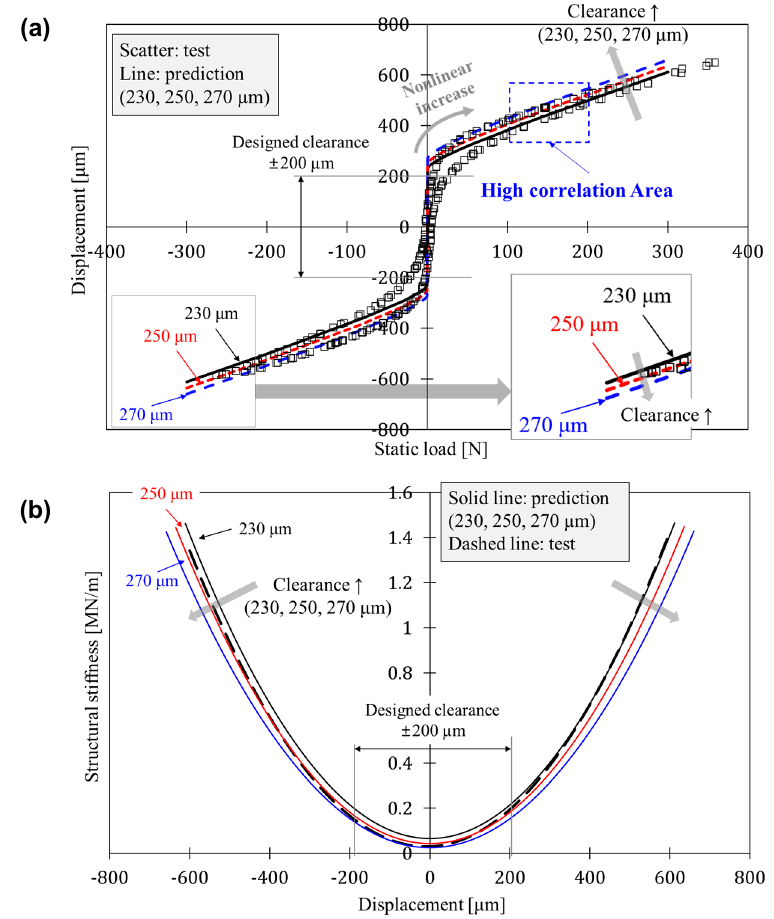
Figure 5. Comparison of the measured and predicted ( a ) displacements versus the applied static loads and ( b ) structural stiffness versus the displacement: prediction cases are clearances of 230, 250, and 270 μ m.